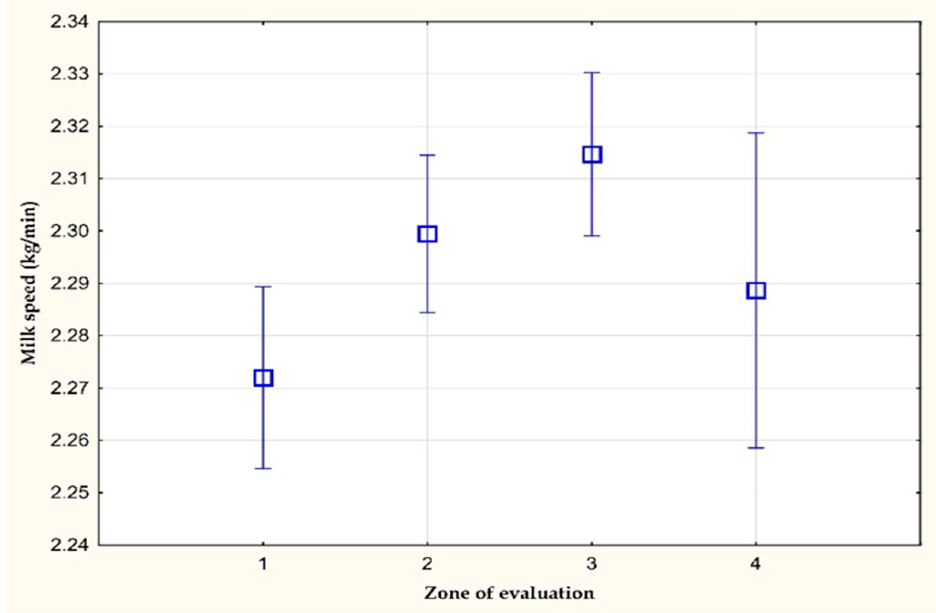
Figure 3. The average milk speed (kg/min) on farm C.